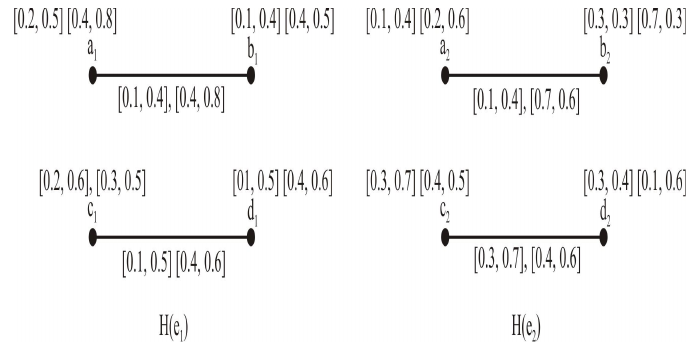
Figure 2: SIVPFSGs ˜ ξ